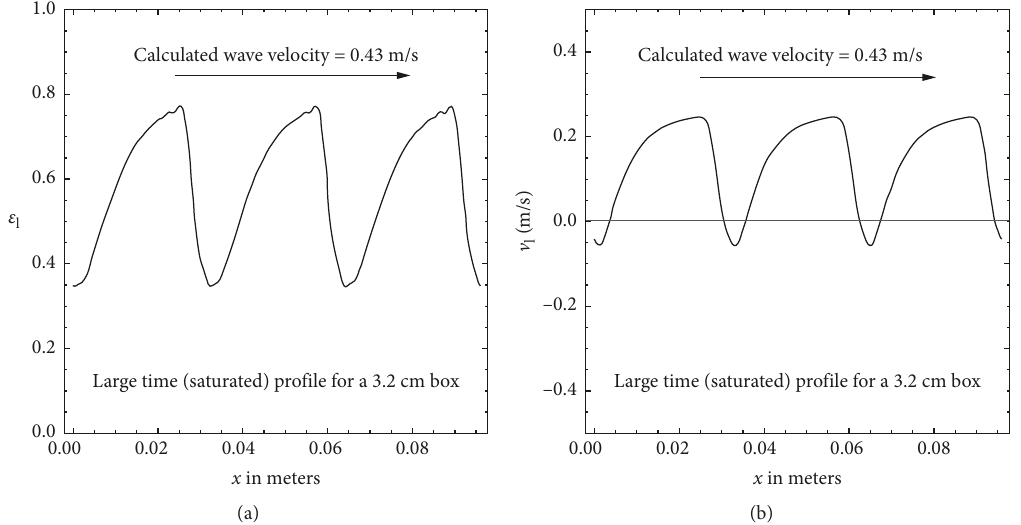
Large time (saturated) profile for a 3.2 cm